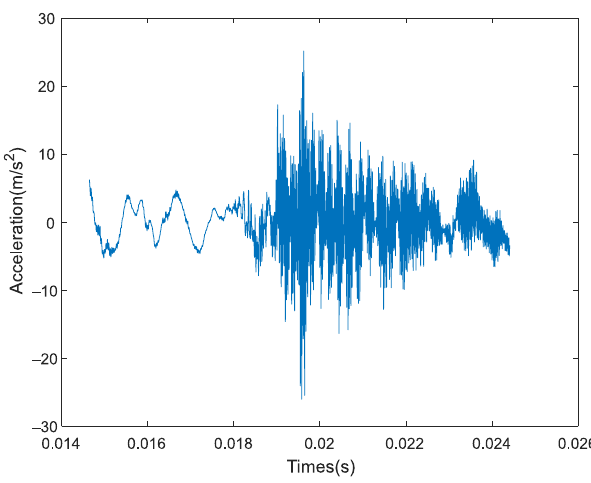
Figure 19. The waveform of intercept signal.